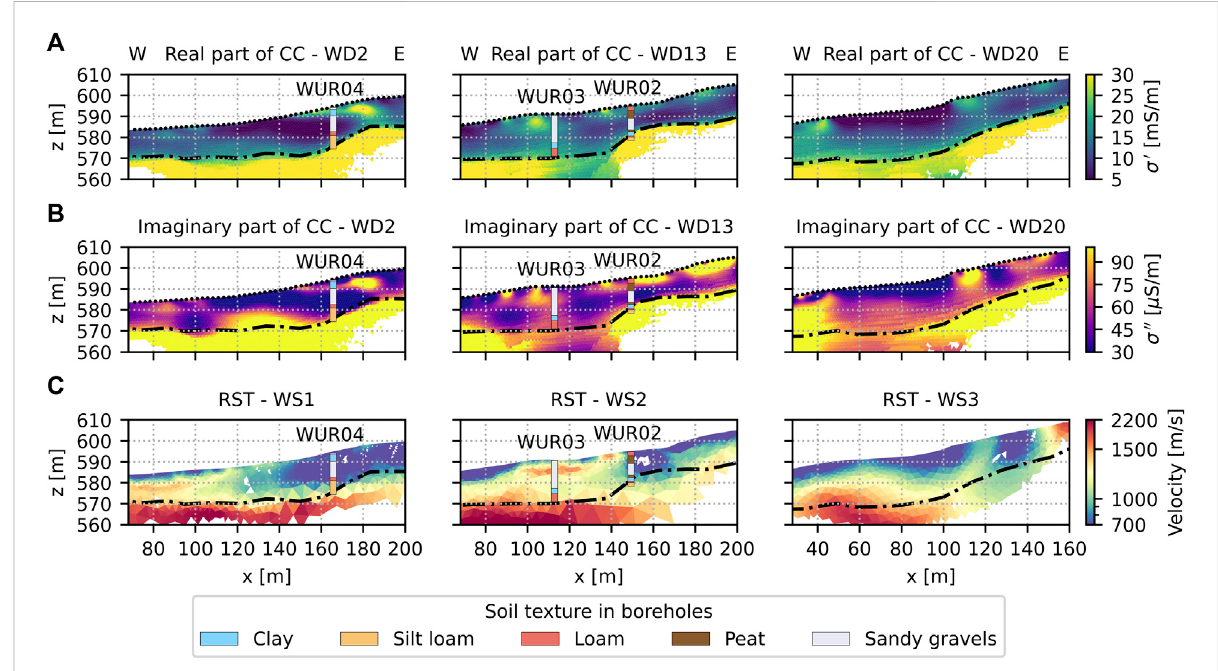
FIGURE 6 (A,B) Complex conductivity imaging results expressed in terms of the real σ ′ and imaginary σ ″ components of the complex conductivity for electrical pro fi les collected at the southern border (WD2), in the center (WD13) and the norther border of the study area (WD20). (C) presents the correspondingseismicP-wavevelocityimagesasobtainedfromRSTfordatacollectedalongtheelectricpro fi les(cf.Figure2).Thedashedblackline indicates the depth and topography of the bottom layer as delineated from the σ ′ imaging